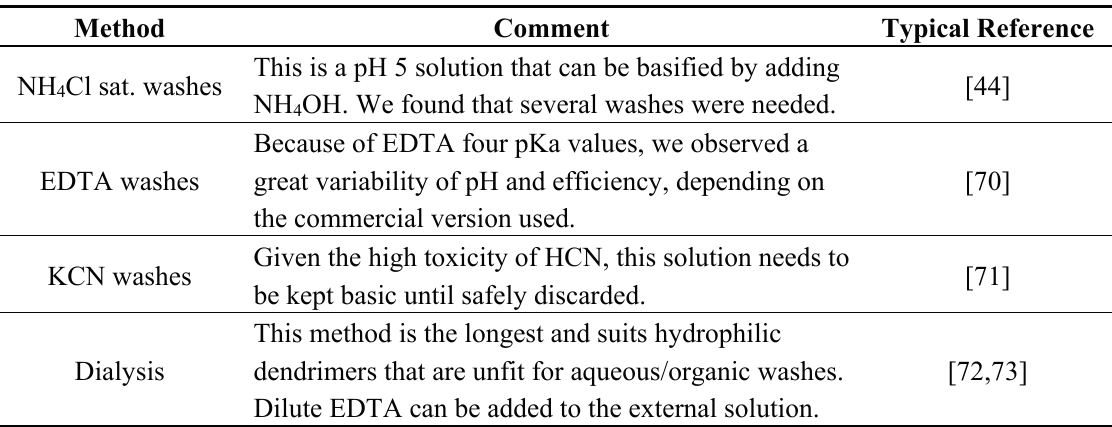
Table 2. Methods used to remove copper from CuAAC in dendrimer synthesis from 2010 to